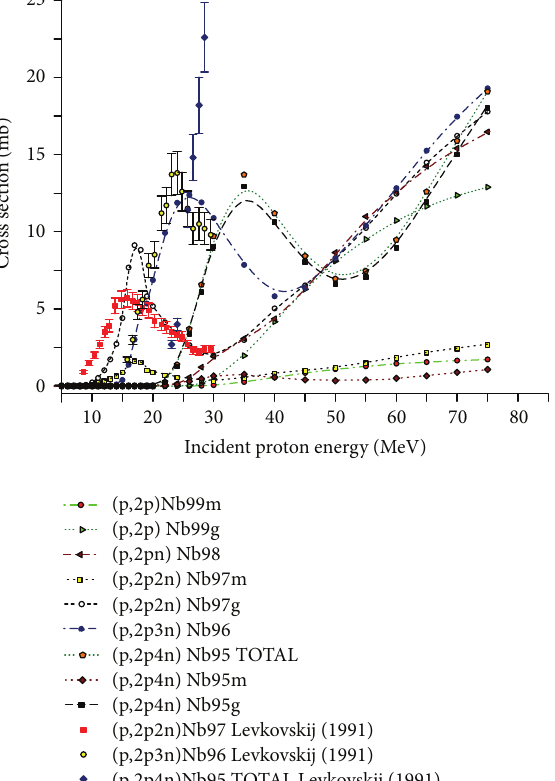
Figure 3: The collection of 100 Mo(p,2pxn) 9𝑥 Nb theoretical excita- tion functions from the TENDL 2012 library [24] up to the (p,2p4n) level. The available experimental measurements by Levkovskij [2] for 95𝑚+𝑔 Nb, 96 Nb, and 97 Nb nuclides are included for